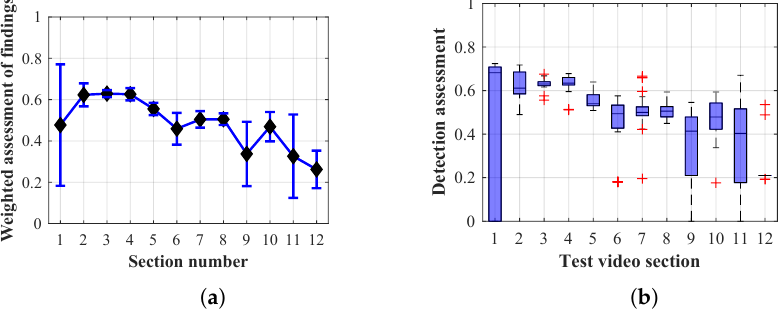
Figure 27. Results of Method 1.1 with a lifespan of 1 frame. ( a ) the weighted average rating with the average mean absolute error of the weighted rating and ( b ) boxplots of the distribution of the statistical sets of the results of the individual sections evaluated indicating: minimum, 1st quartile, median, 3rd quartile, maximum.